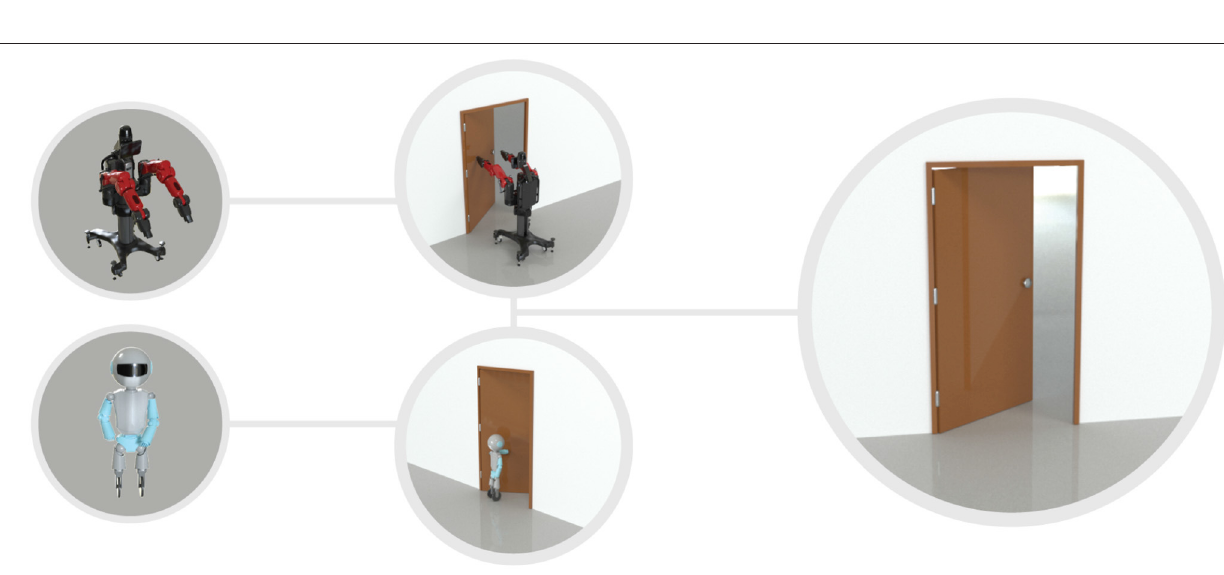
FIGURE 2 | Example of equivalence between different actors and their actions for opening a door. A door can be opened by any robot that can interact with the